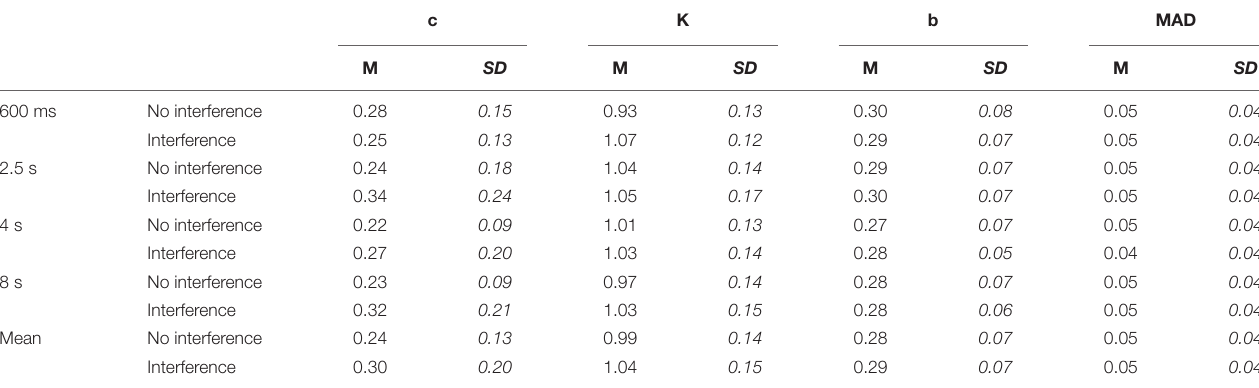
TABLE 2 | Parameter values for the fits of the modified Church and Gibbon model with the individual data obtained in the 24-h delayed test with and without an interference task. c